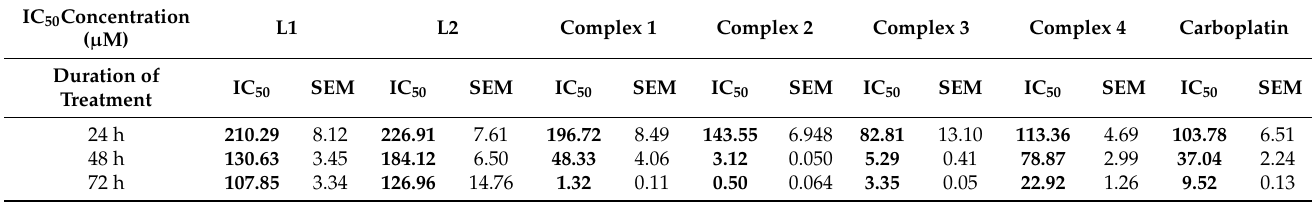
Table 1. Half maximal inhibitory concentrations (best-fit IC 50 values, µ M) of ruthenium